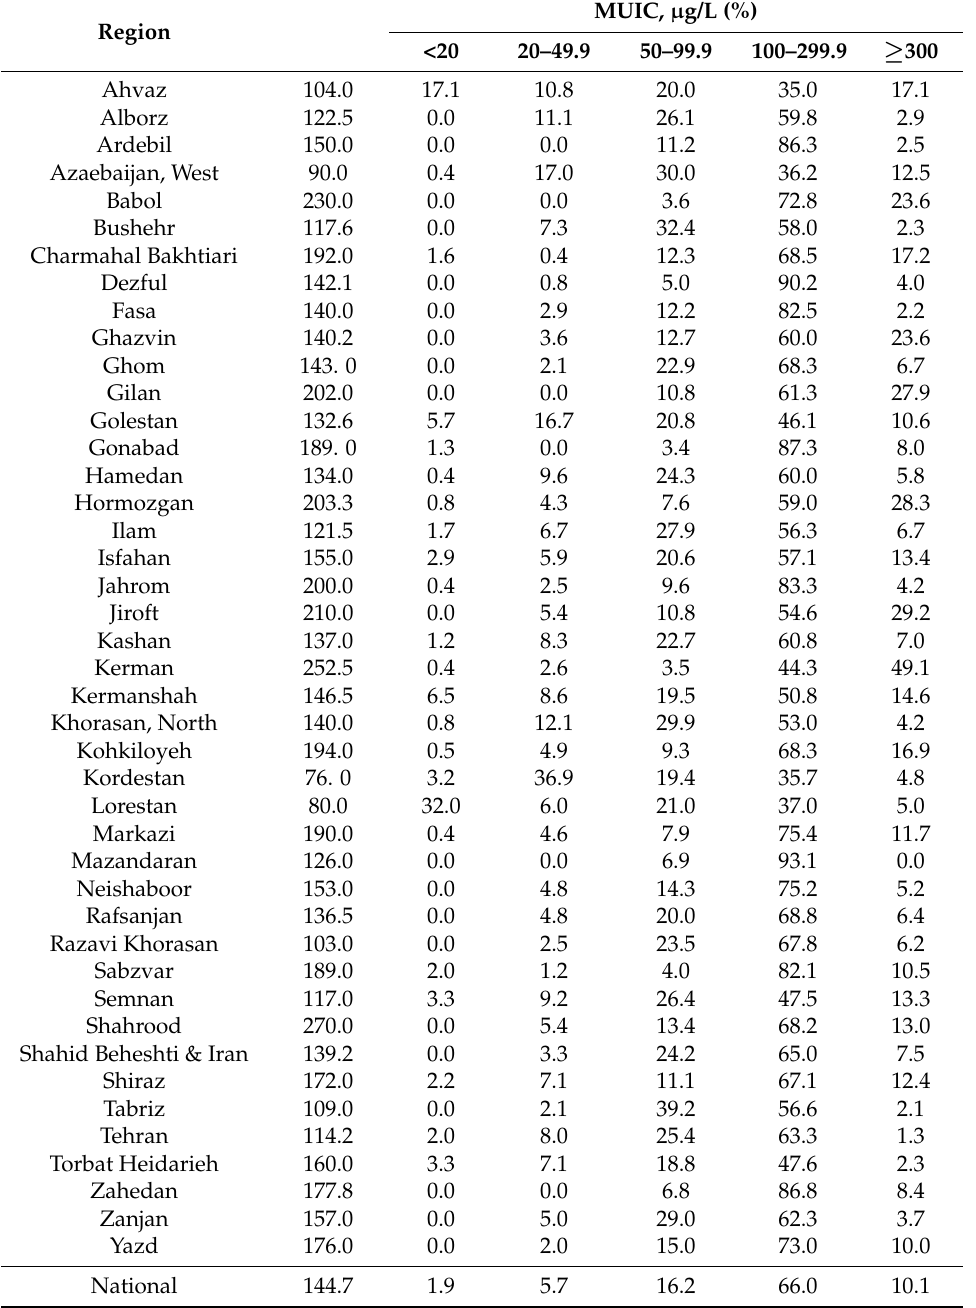
Table 2. Median urinary iodine concentration (MUIC) in school-aged children in national monitoring program for iodine deficiency by university of